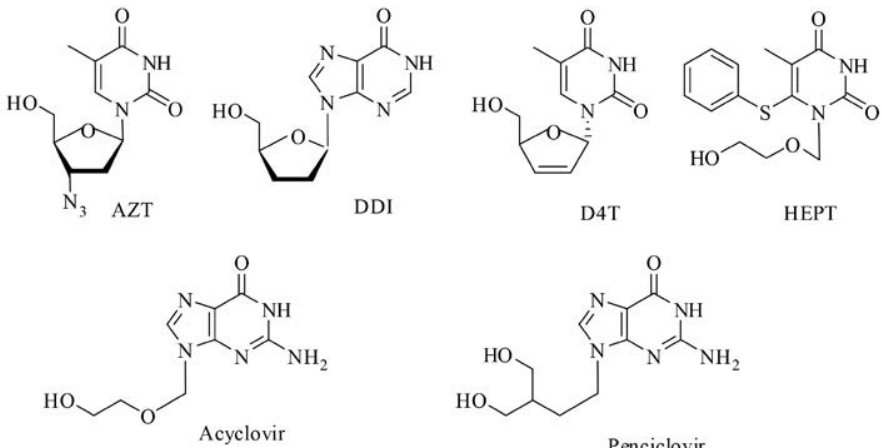
Figure 1: Some examples of cyclic and acyclic antiviral